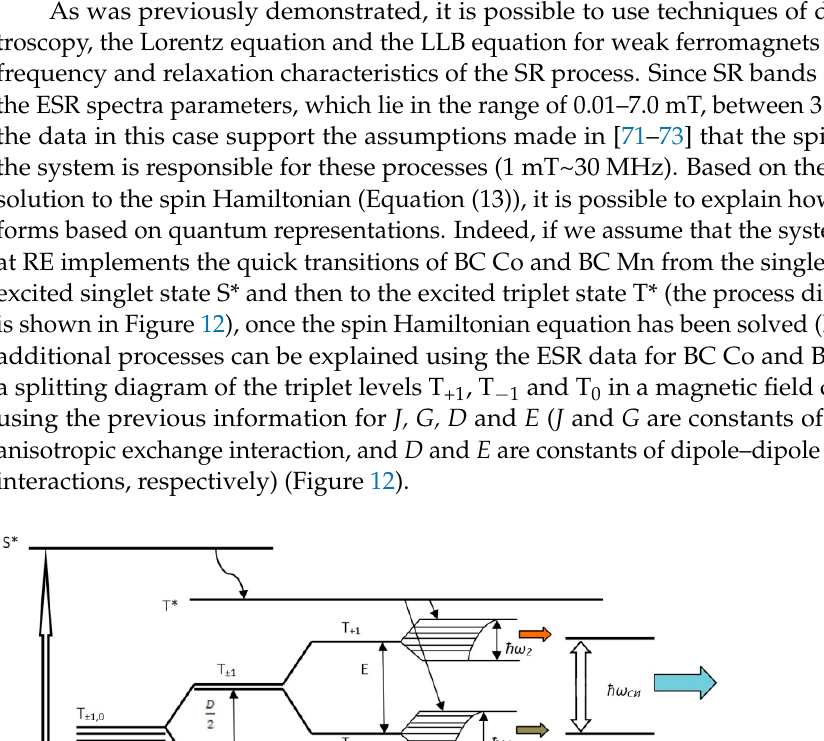
Figure 11. ( a ) Fourier image of the electrical signal for PS and the radiation bands obtained by the Havriliak–Negami method (the parameters are given in Table 4). ( b ) Fourier approximation of the image of the electrical signal for the composite K5 according to the Havriliak–Negami model (the band parameters are given in Table 4). ( c ) Relaxation time distribution curves g ( τ ) for PS matrix and composite K5. The numbers of the radiation bands and curves g ( τ ) correspond to the numbers in Table 4 (From [48] with permission).